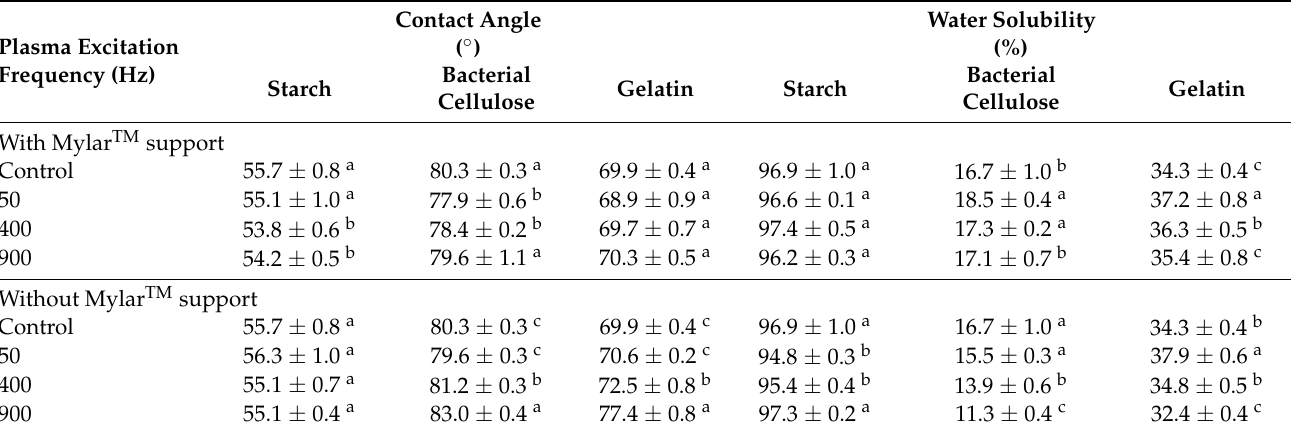
Table 2. The angle of contact and water solubility of the starch, bacterial cellulose, and gelatin films treated with dielectric barrier discharge plasma: with and without Mylar™ support. For each property, values followed by at least one common letter are not different from each other ( p >